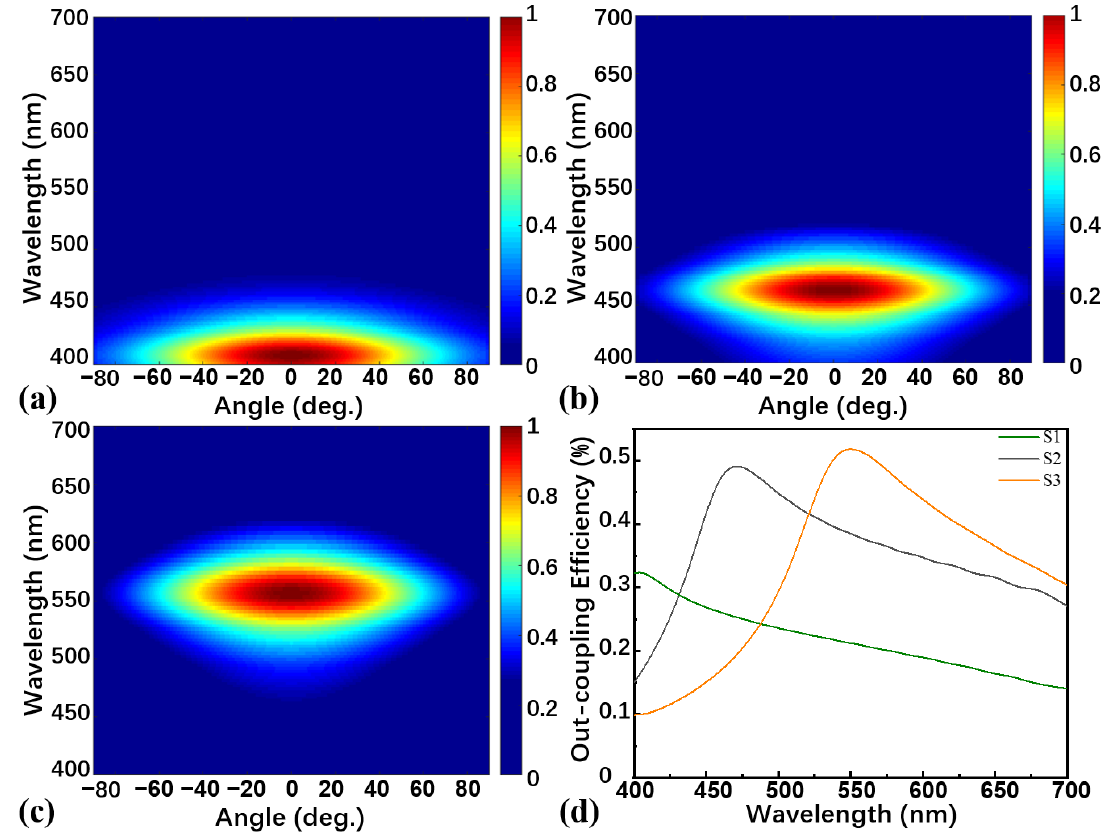
Figure 2. FDTD simulation of angle-wavelength-dependent normalized emission intensities of ( a ) device S1, ( b ) device S2, and ( c ) device S3; ( d ) FDTD simulation of light out-coupling efficiency of devices S1, S2, and S3.